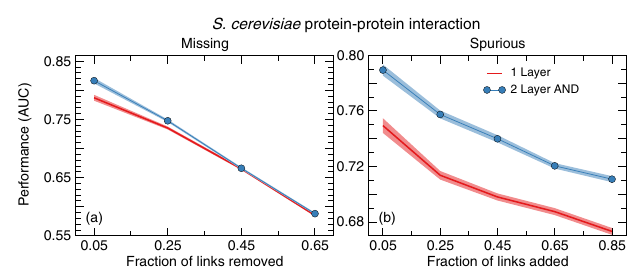
FIG. 4. Performance of missing and spurious link identification on a real multilayer network. We show the accuracy at detecting (a) missing and (b) spurious interactions in the protein-protein interaction network of S. cerevisiae, obtained from the BioGRID database [50], by aggregating two layers as described in the text. To compare the performance of the different approaches at detecting missing links (a), we randomly remove a fraction of the links (false negatives) from the real network and calculate the reliability of each unobserved link. Then we calculate the AUC statistic; that is, we rank the links by decreasing reliability and calculate how often a removed link (false negative) has a higher reliability than a link that does not exist in the original network (true negative). Analogously, to detect spurious links (b), we randomly add a fraction of links (false positives), calculate the reliability of the observed links, and calculate how often an added link (false positive) has a lower reliability than a link that exists in the original network (true